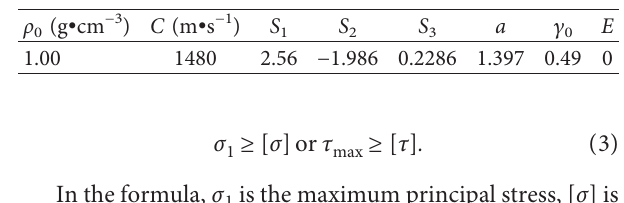
Table 1: Conductive parameters for UHP-WJ.